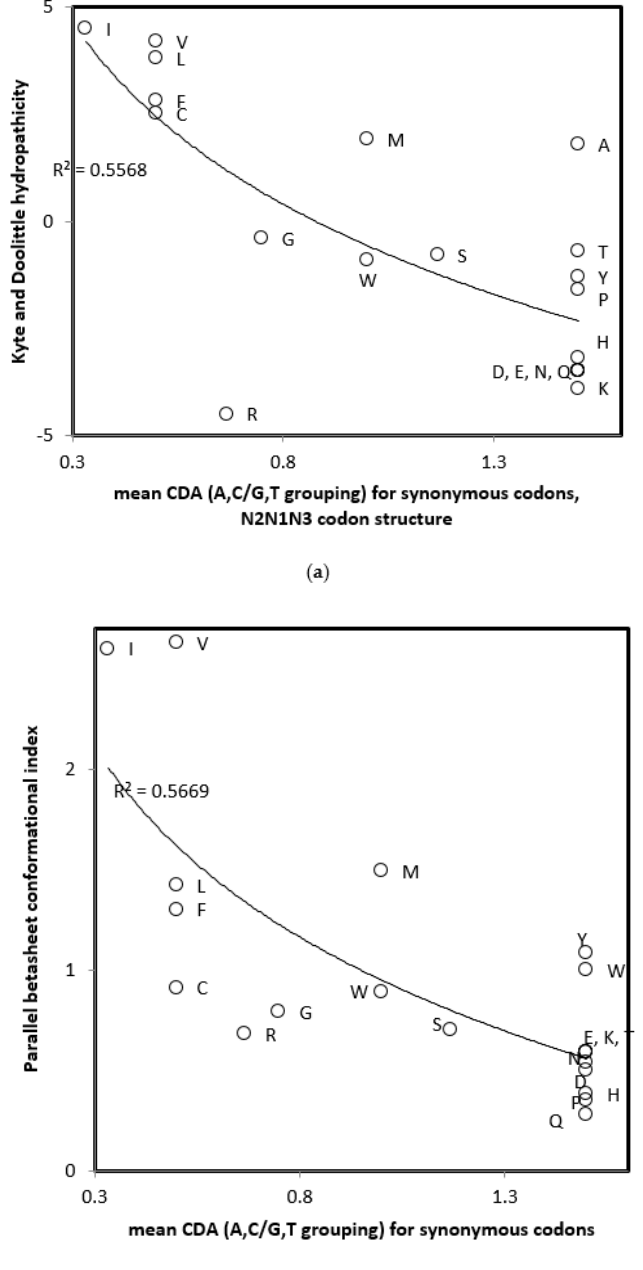
Figure 1. Correlations of amino acid physicochemical and structural properties with mean CDA for synonymous codons according to swapped N2N1N3 codon structure and tautomeric isoforms, from Table 2. ( a ) Kyte and Doolittle hydropathicity; and ( b ) parallel beta sheet conformational index.